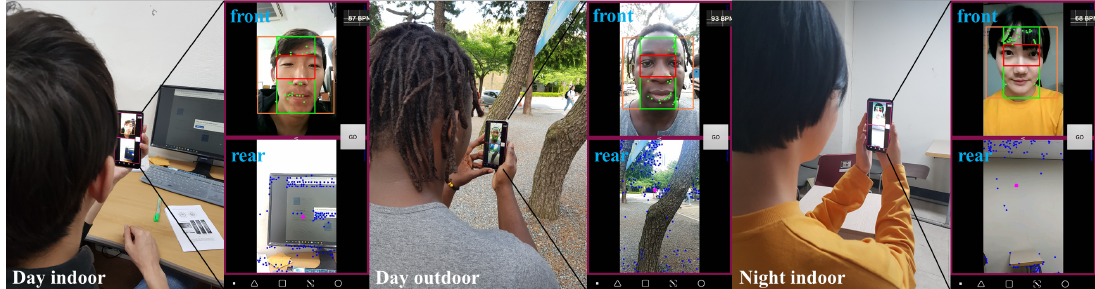
Figure 6. Heart-rate measurement in different illumination conditions. For each condition, the right images represent the main screen of the proposed